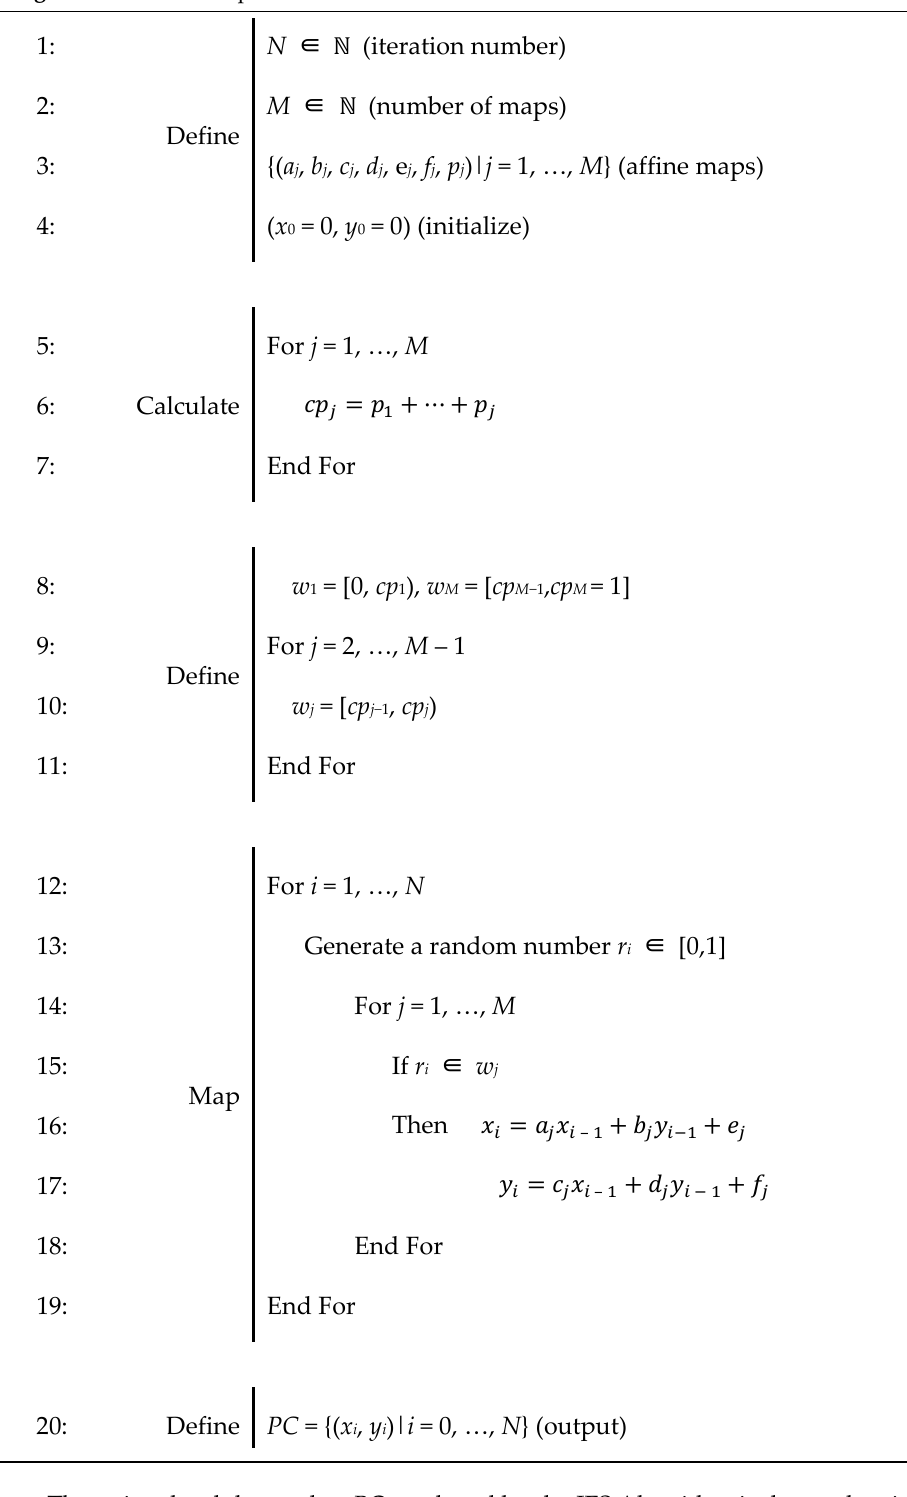
Algorithm 1: The main processes of the Algorithm 1 The main processes of the IFS